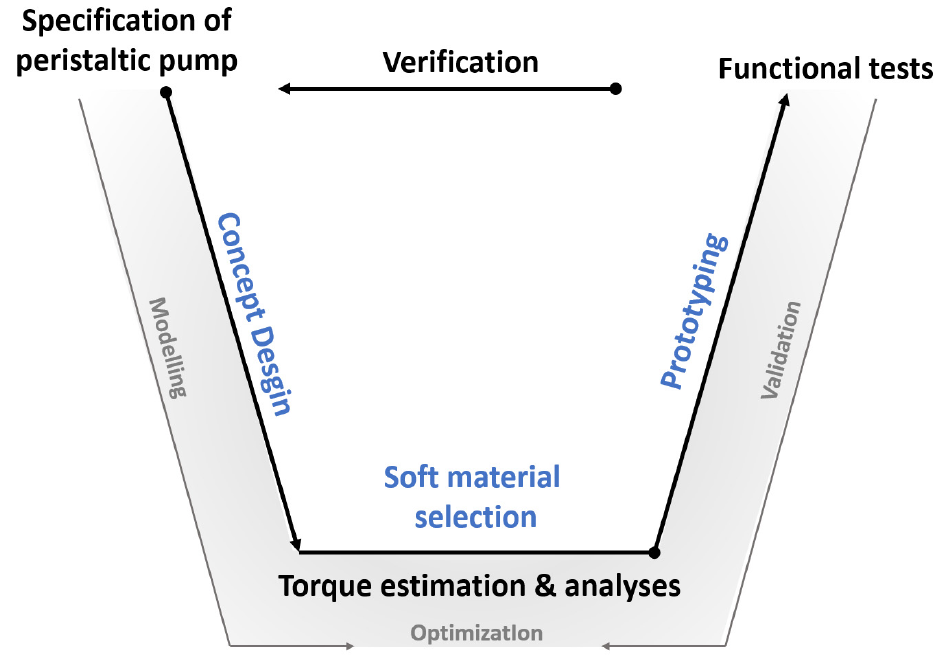
Figure 2. V-model of the peristaltic micro-dosing pump.